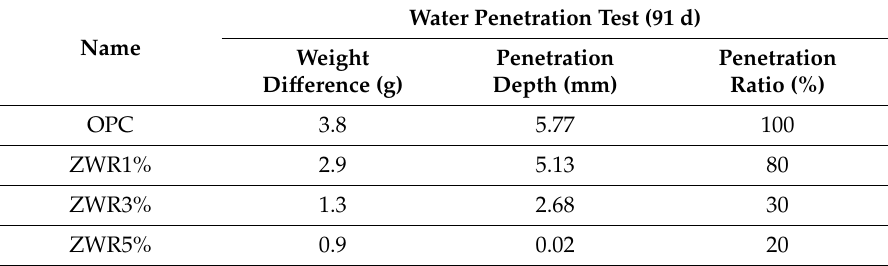
Table 14. Data of accelerated carbonation test (91 days).